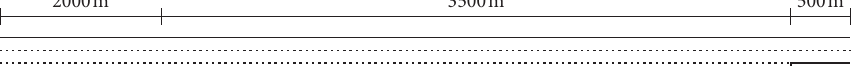
Figure 3: Layout of the freeway section used for assessment.